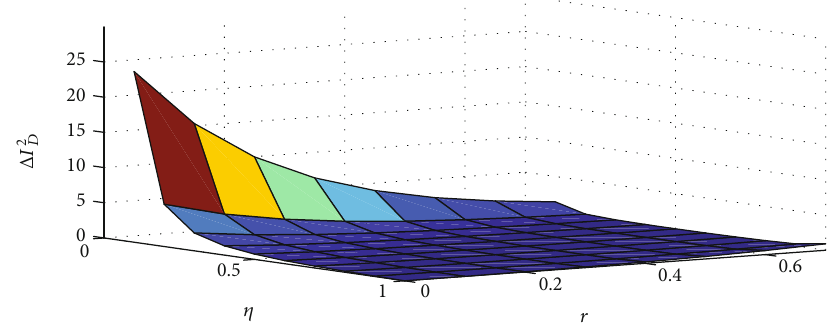
Figure 7: Plots of intensity di ff erence fl uctuation (Equation (32)) versus η and r for A = 100 and κ = 0 : 8 .